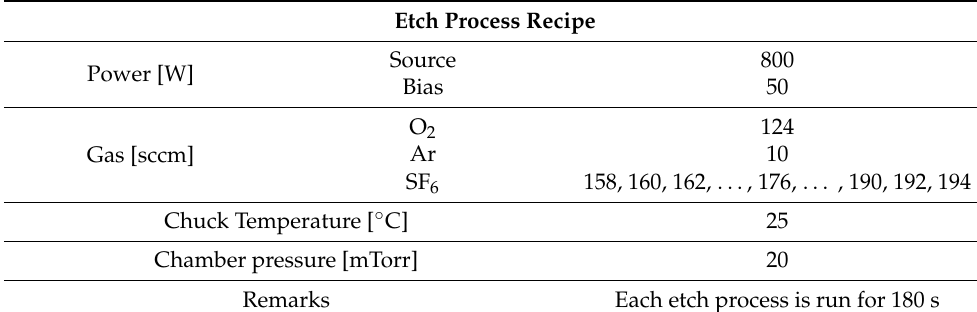
Table 1. Description of the etch process